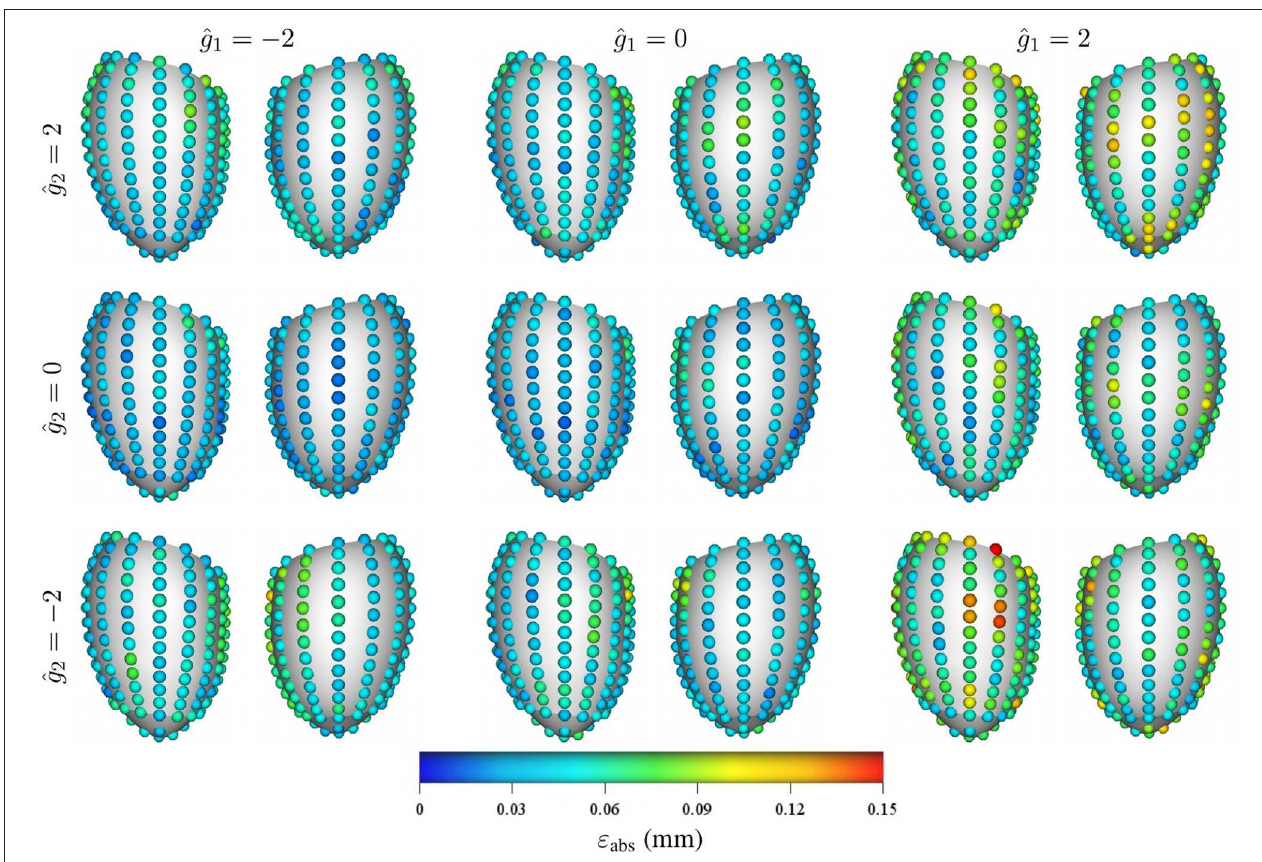
FIGURE 9 | Mean intramural spatial distribution of ε abs for a fixed set of mechanical properties p g 1 geometric parameter 2, 0, and 2; and (bottom to top) variations in the geometric parameter ˆ = − of the heart is shown on the left and the anterior surface is shown on the